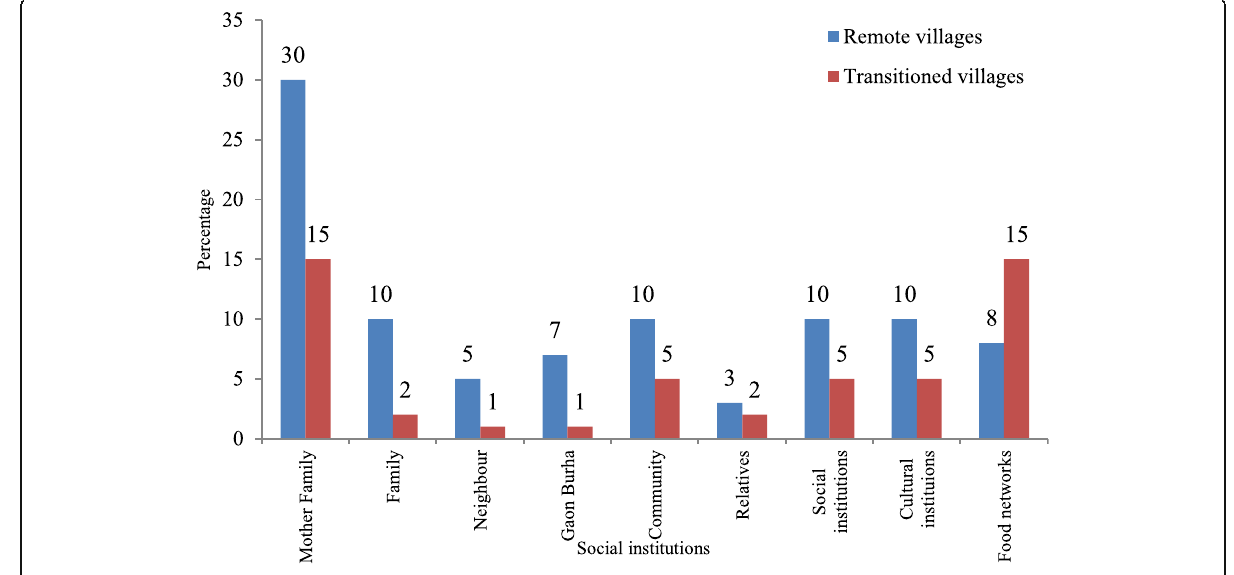
Fig. 6 Intergenerational knowledge transfer through various